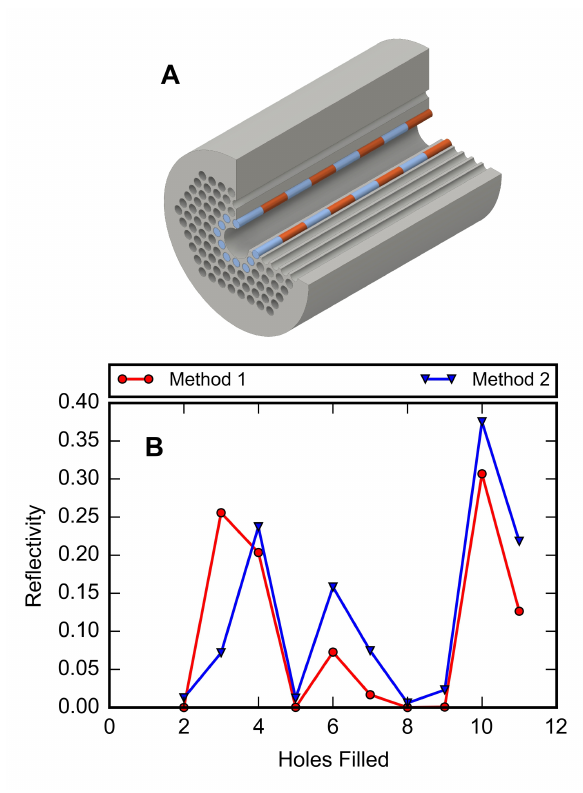
Fig. 6. (A) The second method of index modulation is shown, in which the photonic crystal holes are selectively filled with a poly- mer. (B) The corresponding maximum reflectivities that can be achieved using a perfect Bragg reflector with optical losses asso- ciated with the fiber are shown for polymer in the photonic crystal region (in which the holes in the first layer are filled one at a time in a counter-clockwise direction). See Figure 5 for a description of the Method 1 and Method 2 calculations of the maximum reflectivity.